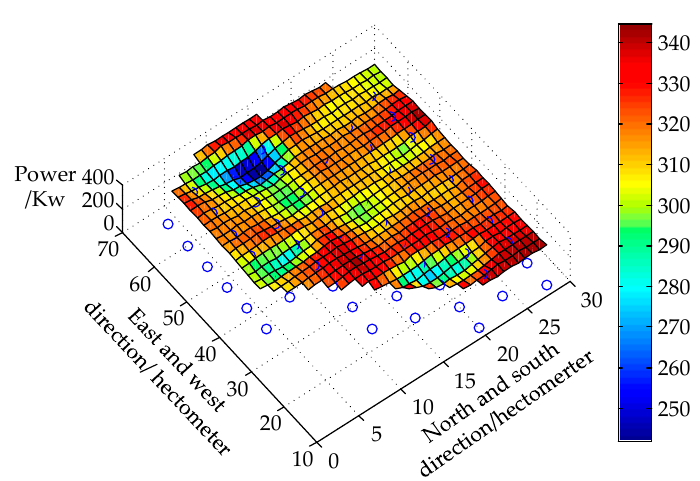
Figure 8. Monthly average power distribution.